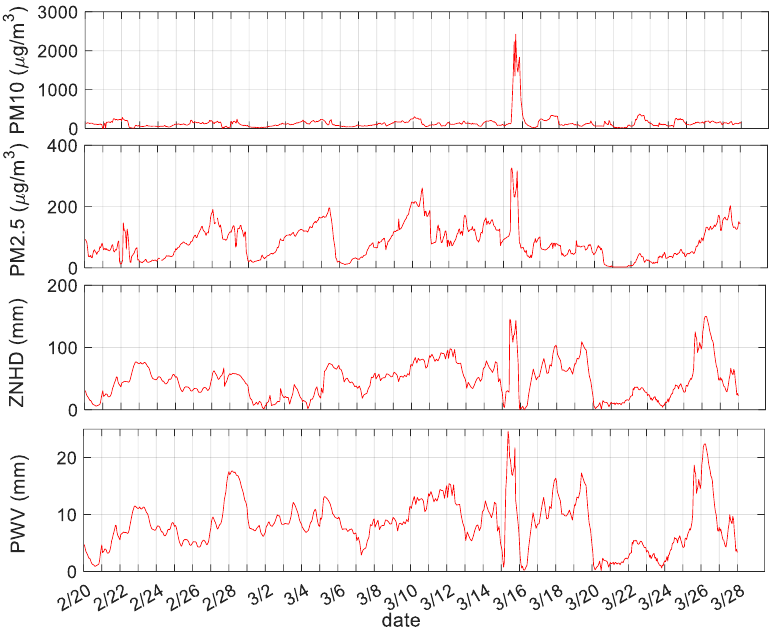
Figure 3. Changes in PM10, PM2.5, zenith wet delay (ZNHD) and precipitable water vapor (PWV) at BJFS station.